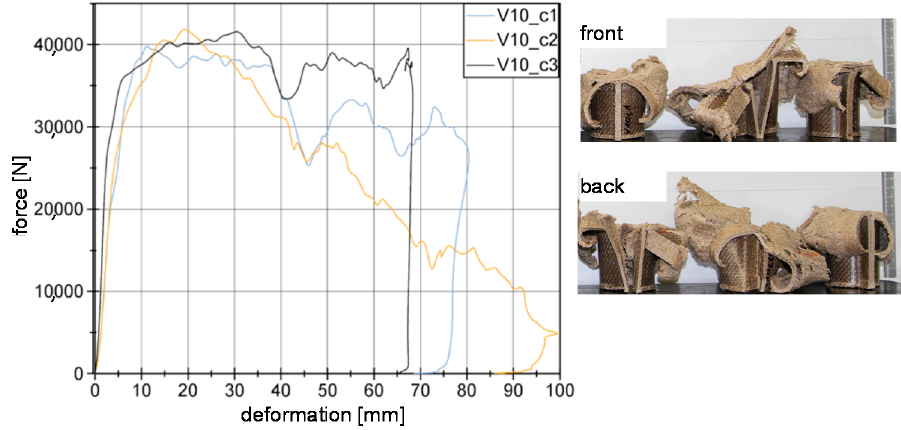
Figure 11. Series c of V10 material in force-deformation curves as an example.